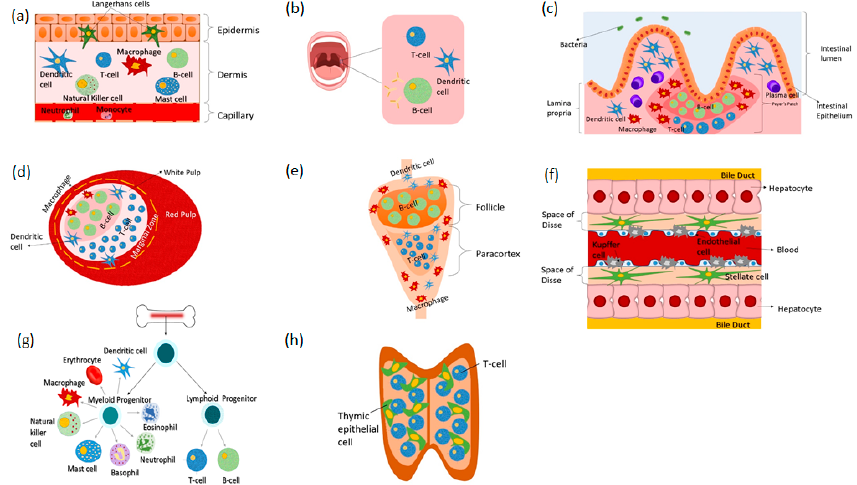
Figure 1 . Organs of the immune system and their associated immune cellular components. (a)